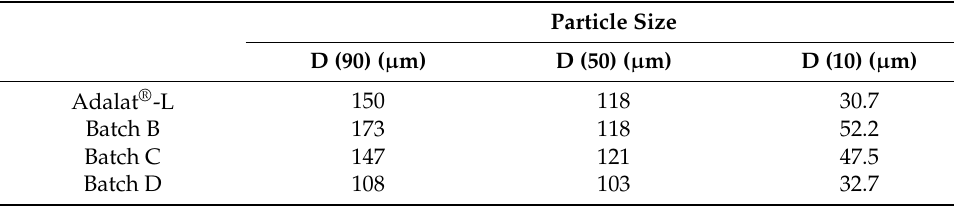
Table 5. Particle size of nifedipine in prepared tablets and Adalat ® -L.